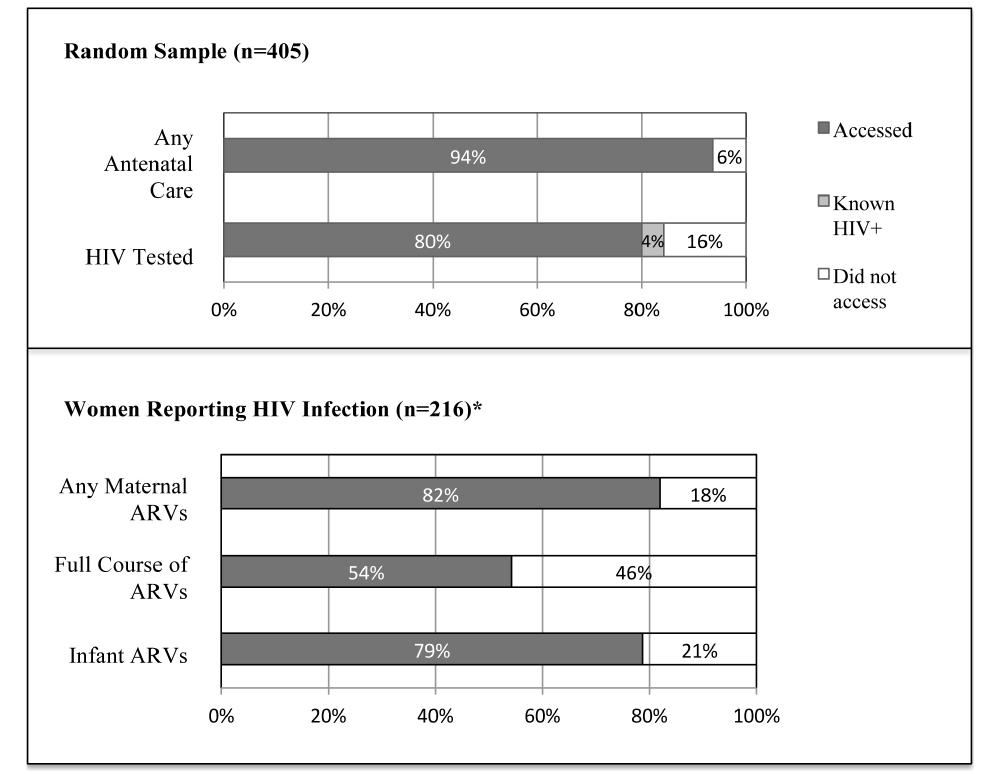
Figure 2. Uptake throughout cascade of PMTCT Services among Women in the Demographic Health Surveillance System Area, Nyanza Province, Kenya (2011). *Includes HIV + oversample and does not reflect population HIV prevalence.